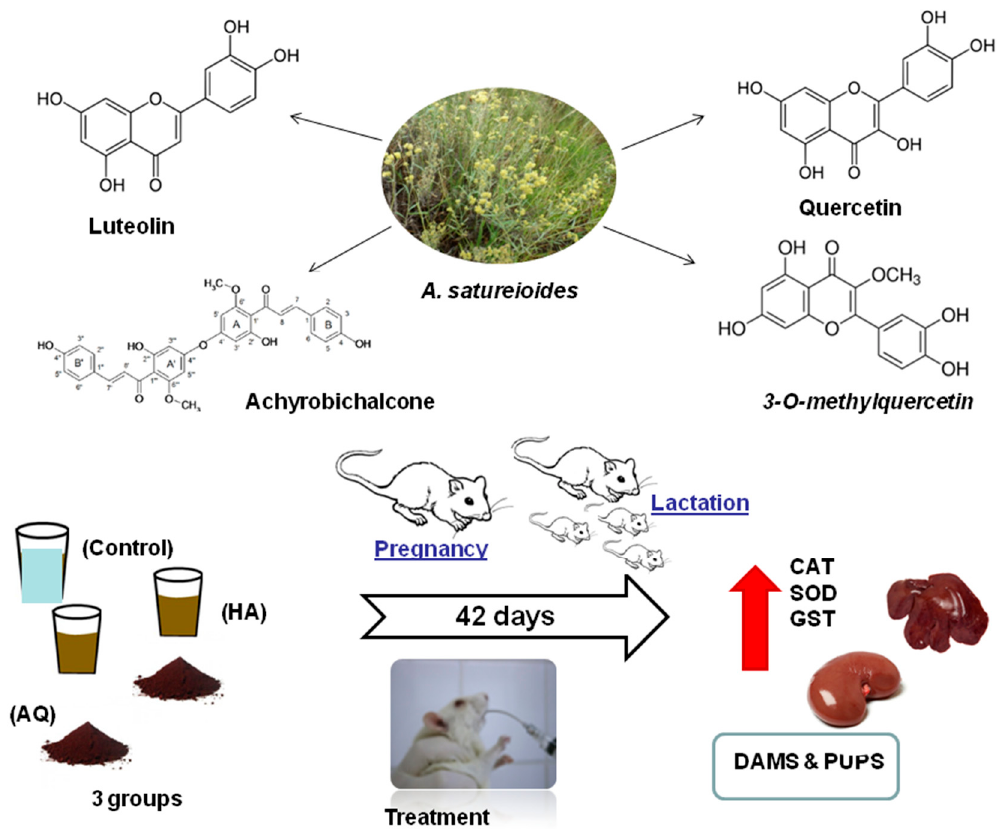
Figure 2. Pregnant and breastfeeding rats supplemented with Achyrocline satureioides inflorescence extracts showed tissue-specific changes in enzymatic activity and lower neonatal survival.